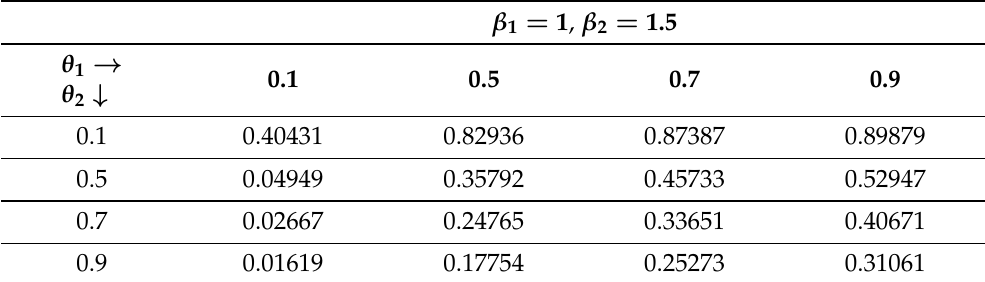
Table 5. Numerical values of Re Stress − Strength associated with the DPsL distribution at β 1 = 1, β 2 = 1.5 for different values of θ 1 and θ 2